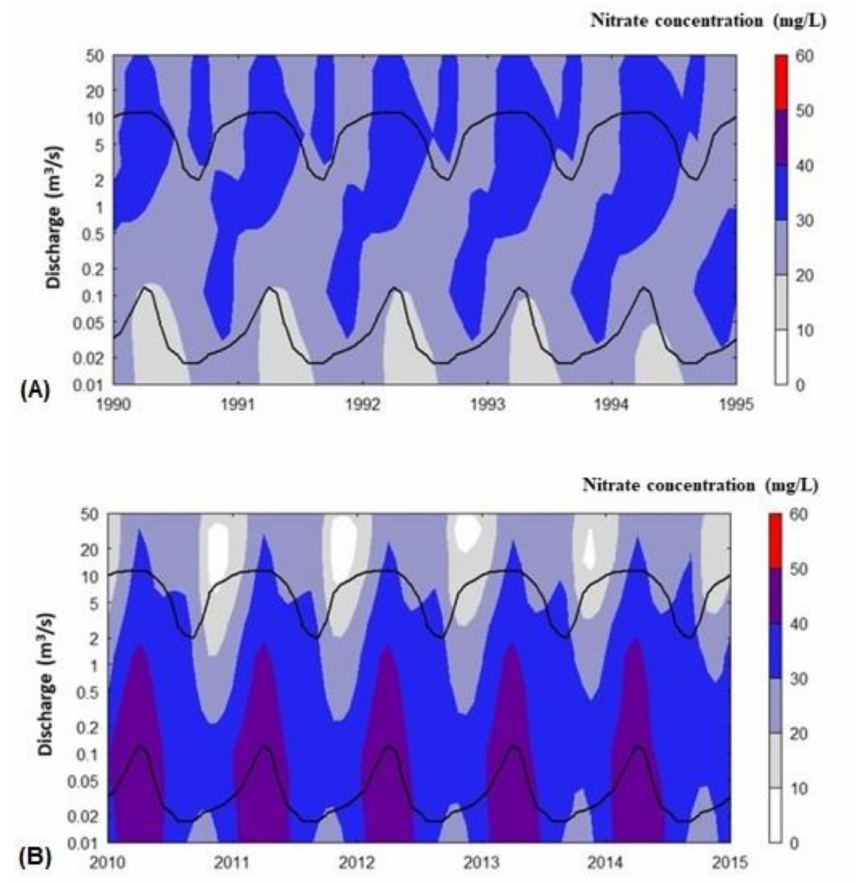
Figure 8. Contour plot of the expected nitrate concentration (flow-normalized) for the 1990–1995 ( A ) and 2010–2015 periods ( B ). The higher and lower black line represent the 95th and 5th percentiles of